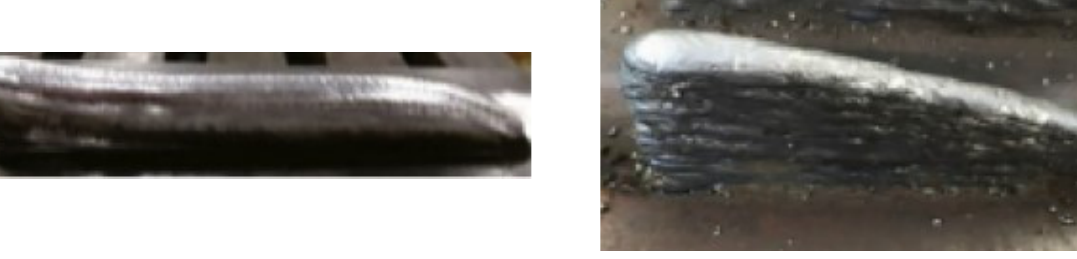
Figure 9. Uneven bead height, adapted from [17].